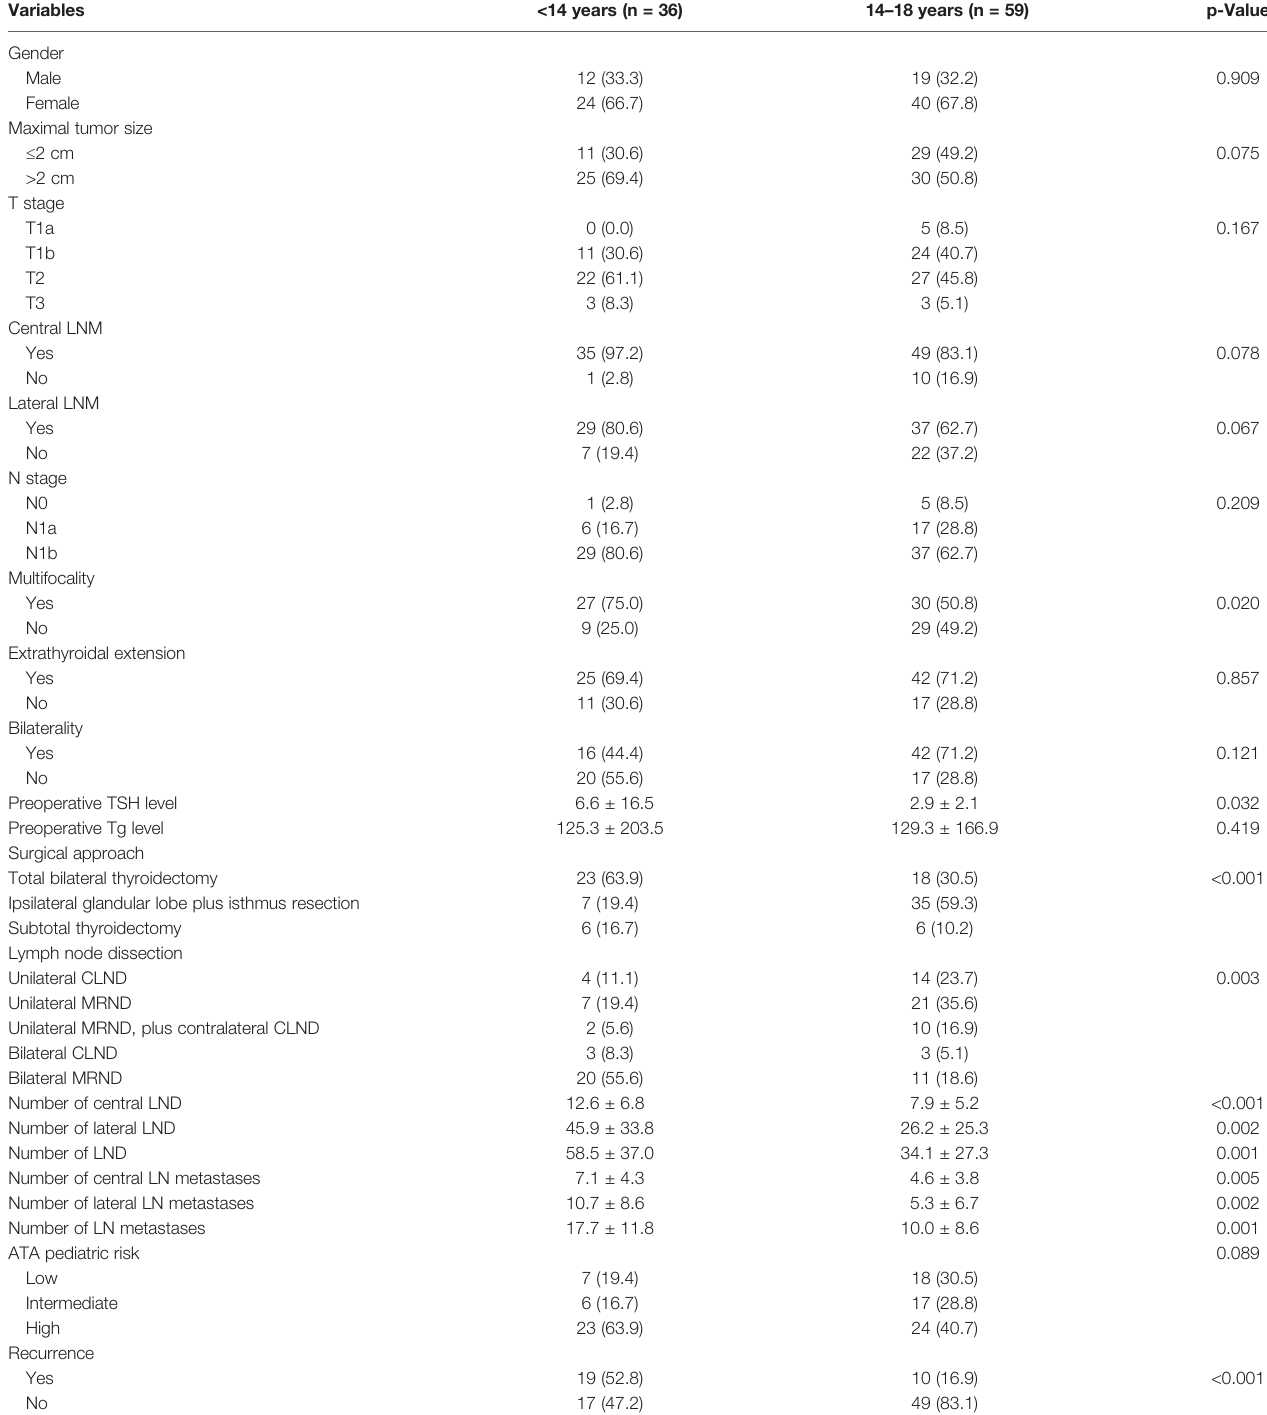
TABLE 2 | Comparison of clinicopathological features of PTC in children and adolescents with different age